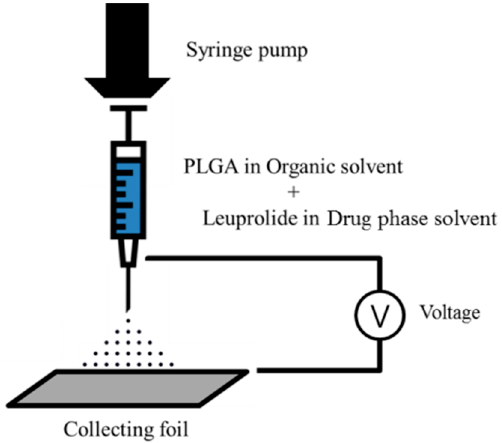
Figure 1. Schematic representation of the electrospraying procedure.